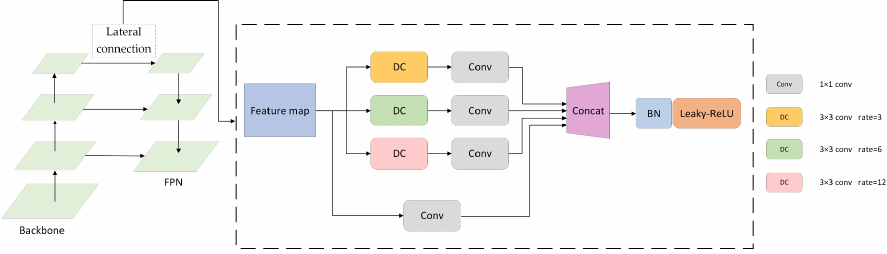
Figure 2. Improvements based on lateral connections in Feature Pyramid Network.